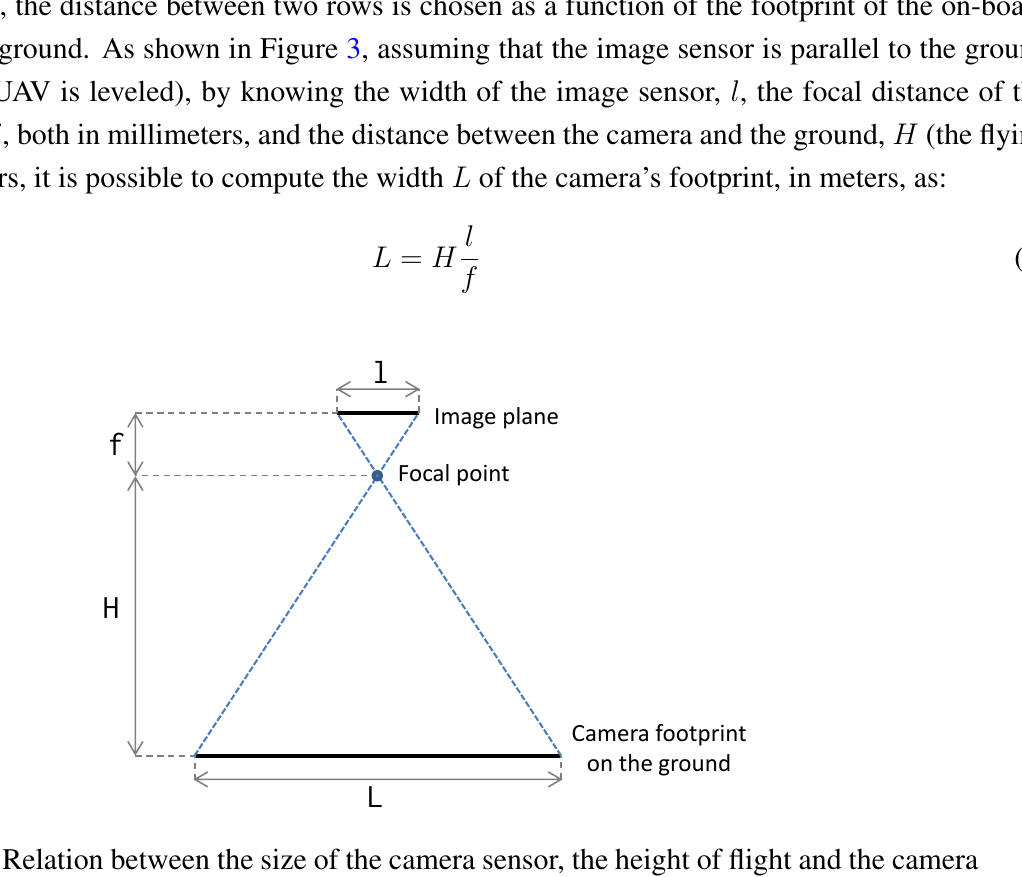
Figure 3. Relation between the size of the camera sensor, the height of flight and the camera footprint on the